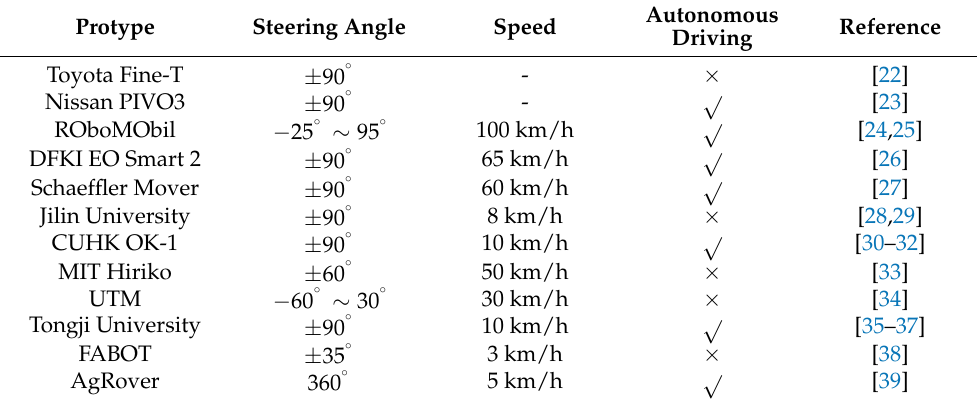
Table 1. Configuration analysis of 4WID-4WIS EV.